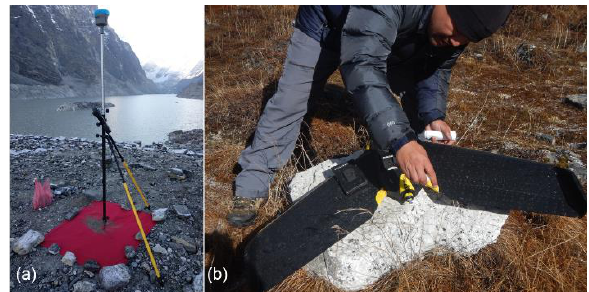
Figure 2. (a) GNSS survey at a GCP overlooking the lake. (b) SenseFly eBee camera setup before flight.